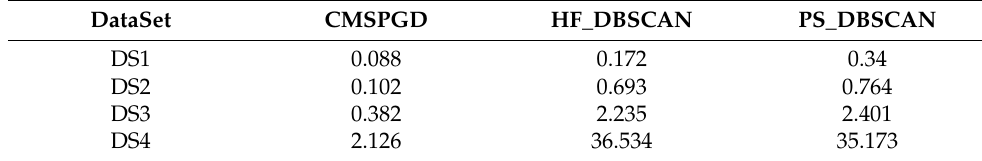
Table 20. Algorithm execution time